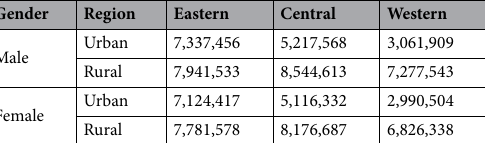
Table 1. Population distribution obtained by the surveillance system in China.